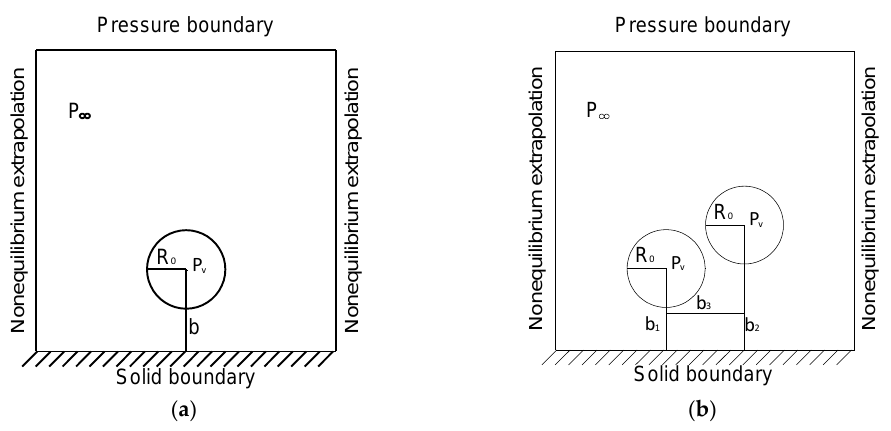
Figure 2. Physical model. ( a ) (single bubble model); ( b ) (double bubbles model) (R 0 —bubble initial radius; b i —distance; P v —vapour pressure in bubble; P ∞ —ambient pressure).